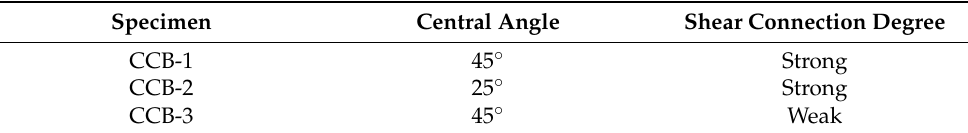
Table 1. Parameters of the test specimens.